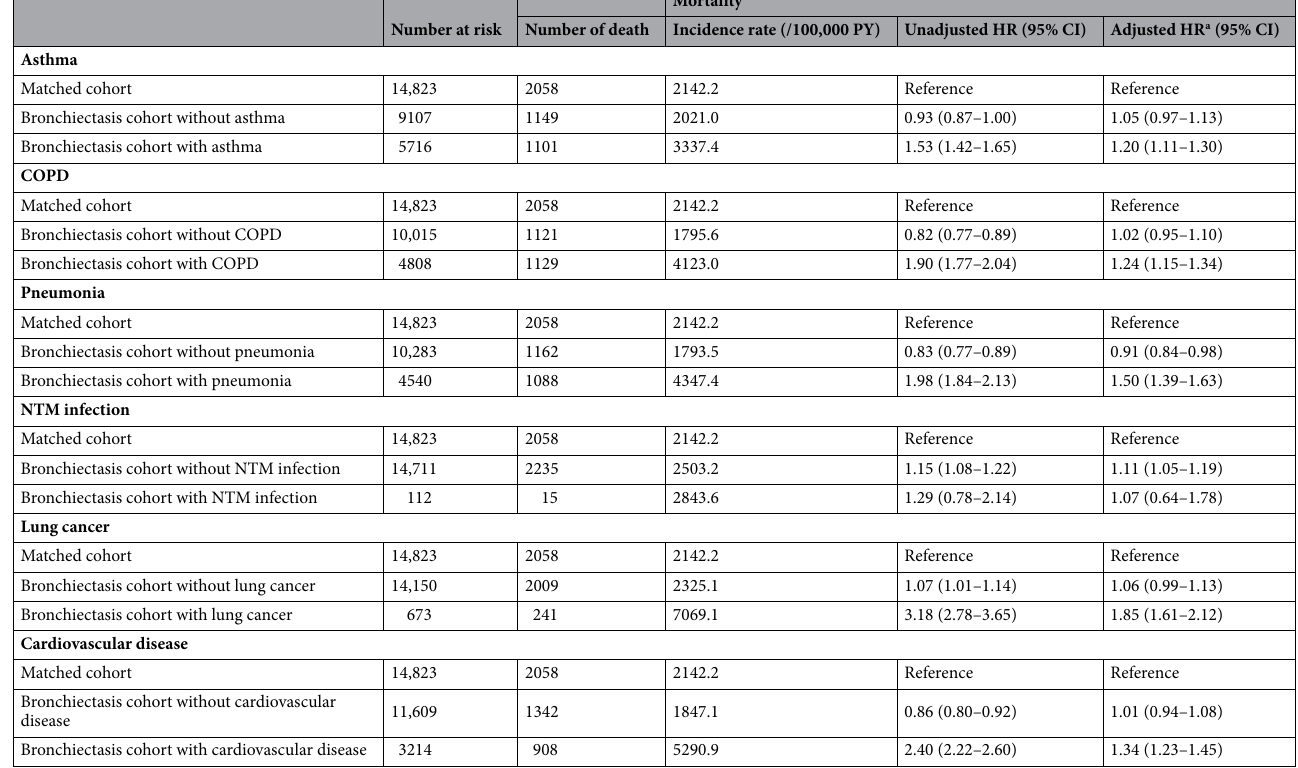
Table 3. The effects of comorbidities over the study period on the risk of mortality in the bronchiectasis cohort relative to the matched cohort. Data are presented as risk ratios (95% confidence interval). Comorbidities, including asthma, COPD, pneumonia, NTM infection, and cardiovascular disease, were assessed at the time of study enrolment as well as during the follow-up period; lung cancer was assessed during the follow-up period. PY, person-years; HR, hazard ratio; CI, confidence interval; COPD, chronic obstructive pulmonary disease; NTM, non-mycobacterial mycobacteria. a Adjusted for age, sex, type of insurance, and Charlson Comorbidity